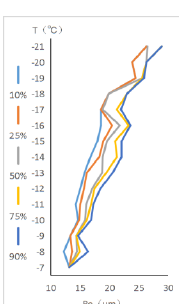
Figure 3. T-Re profiles at 16:38 LST